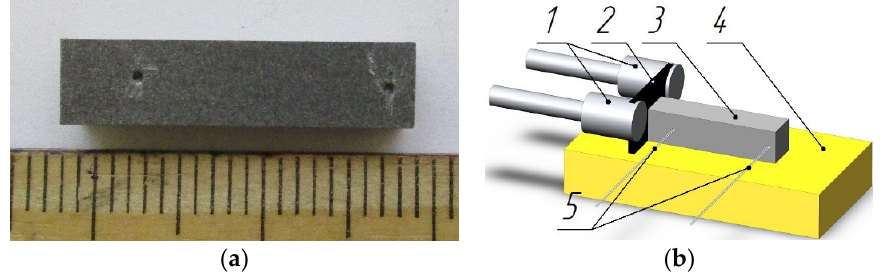
Figure 2. Schematic of the combustion rate measurement: ( a ) specimen; ( b ) rate measurement: (1) current conductor, (2) flat graphite heater, (3) specimen, (4) refractory substrate, (5) WR5/20 thermocouples.